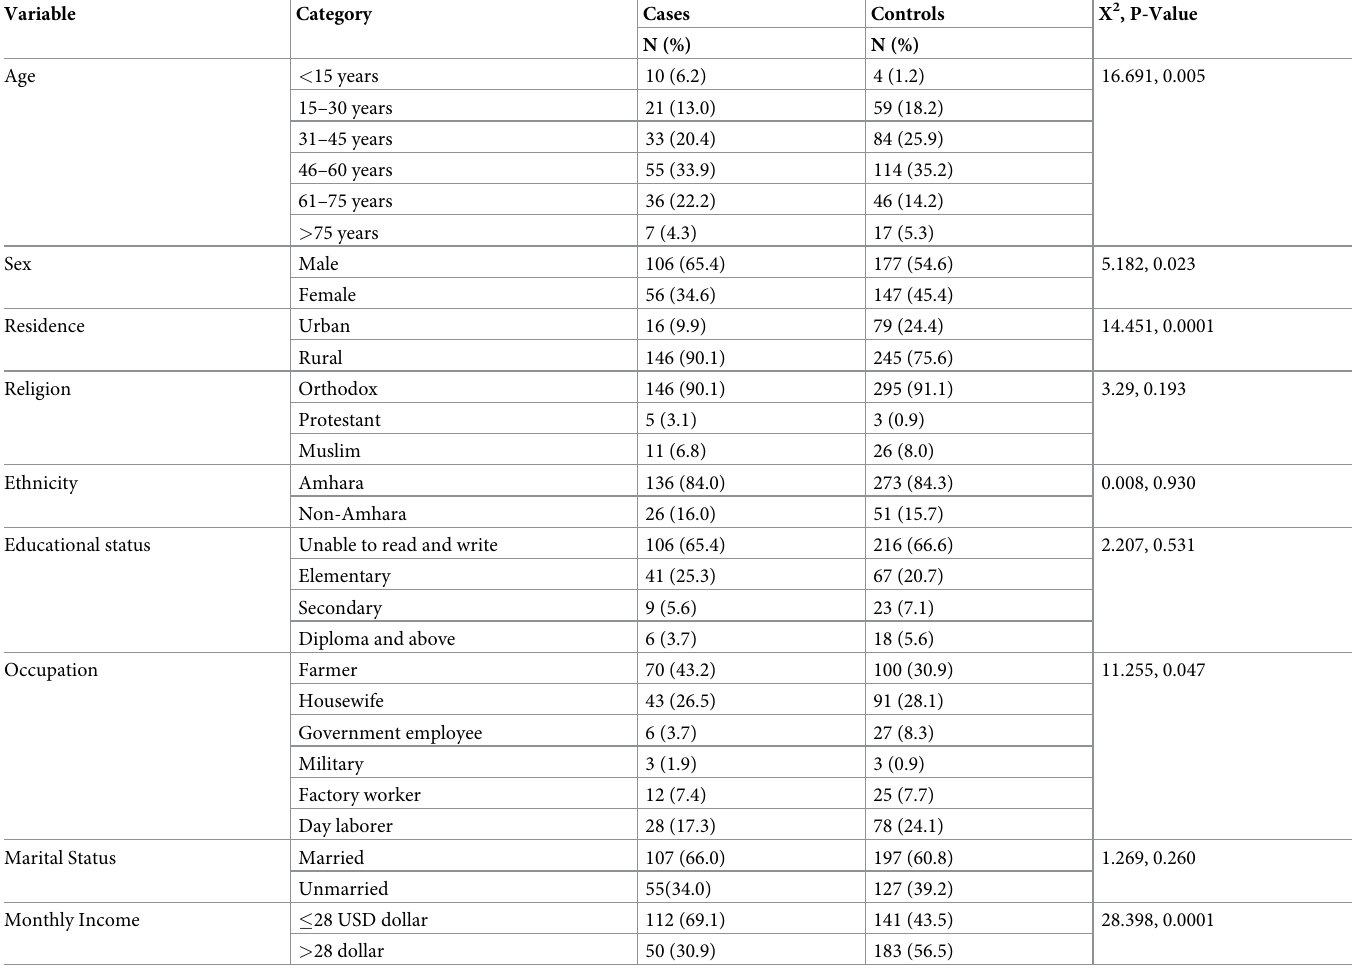
Table 2. Sociodemographic characteristics of the respondents at Felegehiwot specialized hospital, northwest Ethiopia,